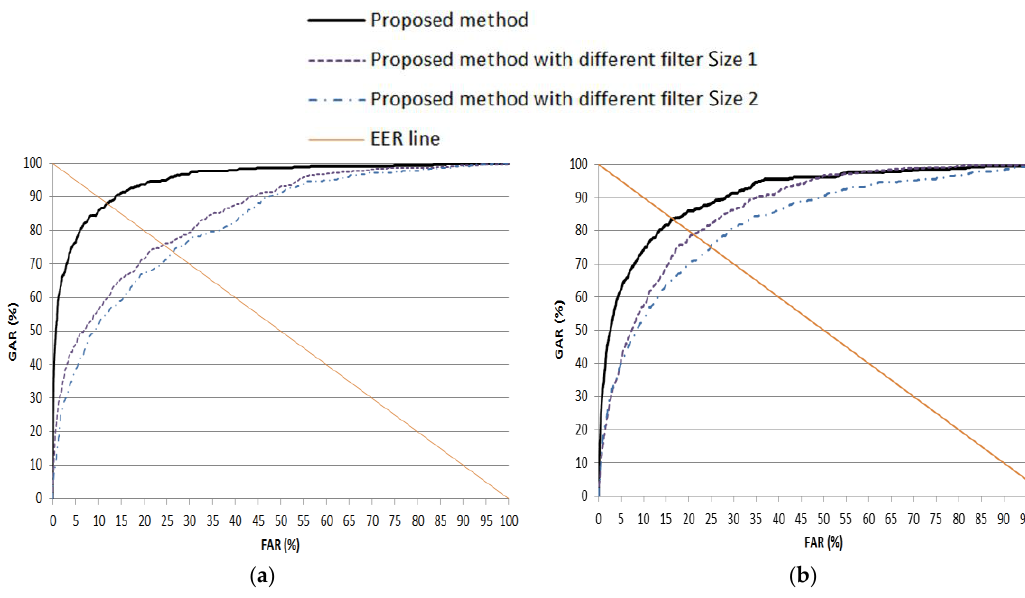
Figure 9. ROC curves of recognition with testing data according to various filter sizes. ( a ) 1st fold cross-validation; ( b ) 2nd fold cross-validation. FAR, false acceptance rate; GAR, genuine acceptance rate. Table 5. Comparisons of recognition accuracies.